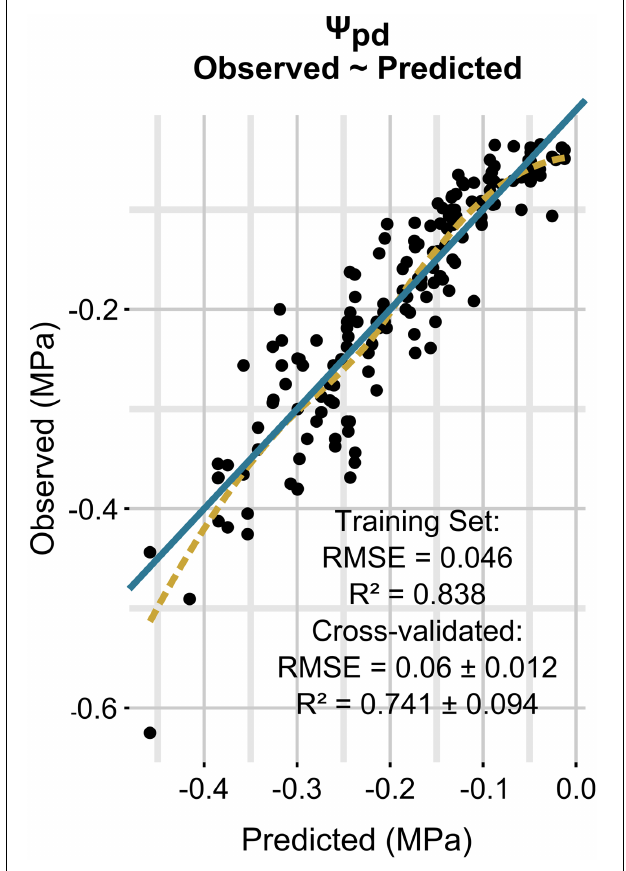
FIGURE 6 | Relationships between observed and predicted (cid:57) pd data (training dataset is shown). The solid line is a line with slope 1 and intercept 0, while the dashed line is a local polynomial regression (loess) fitted to the data.